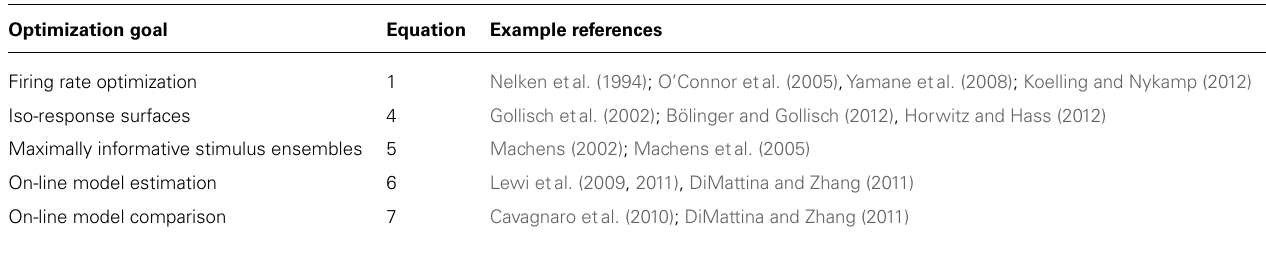
patches shown at the right.The two competing models differ only in their method of integrating subunit activities (additive versus multiplicative). (C) At the end of the estimation phase (“Start”), the BIC does not consistently prefer either model. Presenting additional stimuli optimized for model discrimination yields almost perfect model selection (red curve), while presenting additional random stimuli (green curve), or stimuli optimized for model estimation (blue curve) either does not improve or only somewhat improves model selection.